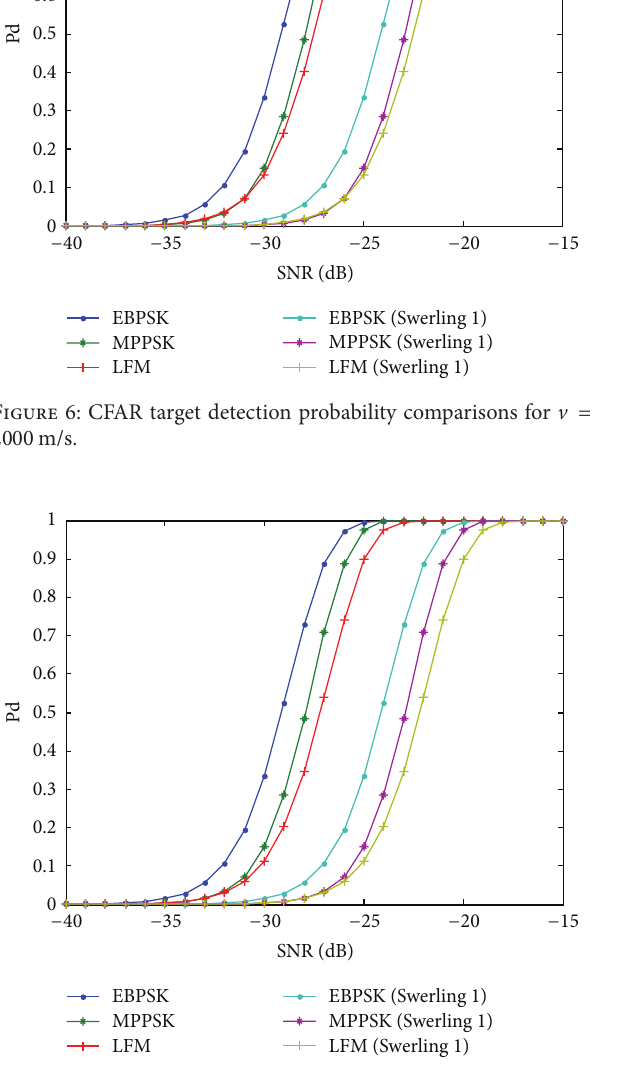
Figure 7: CFAR target detection probability comparisons for V = 3400